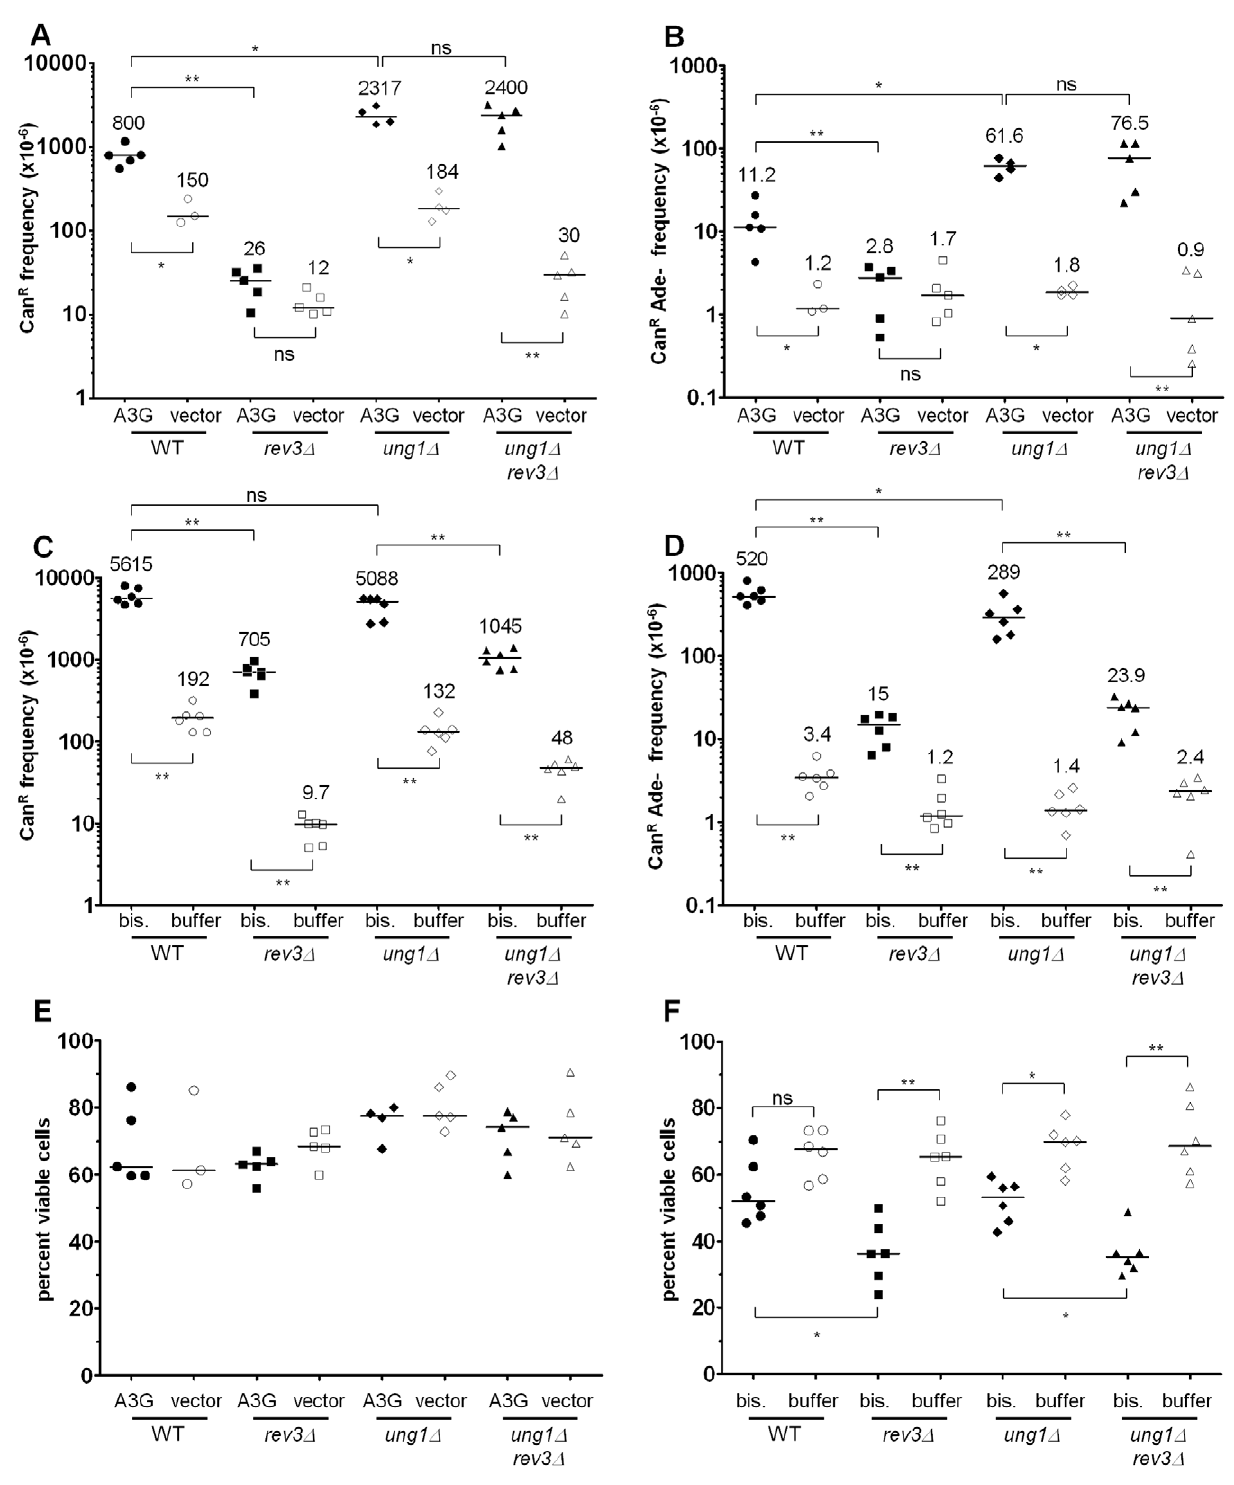
Figure 6. Pol f is involved in the majority of error-prone bypass of the 5,6-dihydrouracil-6-sulfonate intermediate of bisulfite- induced cytosine deamination. (A & B) The frequencies of Can R (A) and Can R Ade 2 (B) in wild-type, rev3 D , ung1 D , and ung1 D rev3 D cells expressing APOBEC3G or bearing empty plasmids are shown. Notice that REV3 , encoding the catalytic subunit of Pol f , is not required for mutagenesis in ung1 D cells expressing APOBEC3G. (C & D) The frequencies of Can R (C) and Can R Ade 2 (D) in wild-type, rev3 D , ung1 D , and ung1 D rev3 D cells that were treated either with bisulfite or with buffer only are shown. Comparison between ung1 D and ung1 D rev3 D cells suggests that Pol f is required for the error-prone bypass of a bisulfite-induced lesion that is distinct from uracil. Taken together with previously published biochemical findings [27,48], these results suggest that the 5,6-dihydrouracil-6-sulfonate intermediate exists in significant quantities in vivo as a consequence of the bisulfite reaction with cytosine. (E) APOBEC3G expression was well-tolerated in rev3 D and ung1 D rev3 D cells. There was no statistically significant difference in viability when compared to WT or ung1 D parental strains, respectively. (F) Bisulfite treatment of rev3 D and ung1 D rev3 D cells resulted in